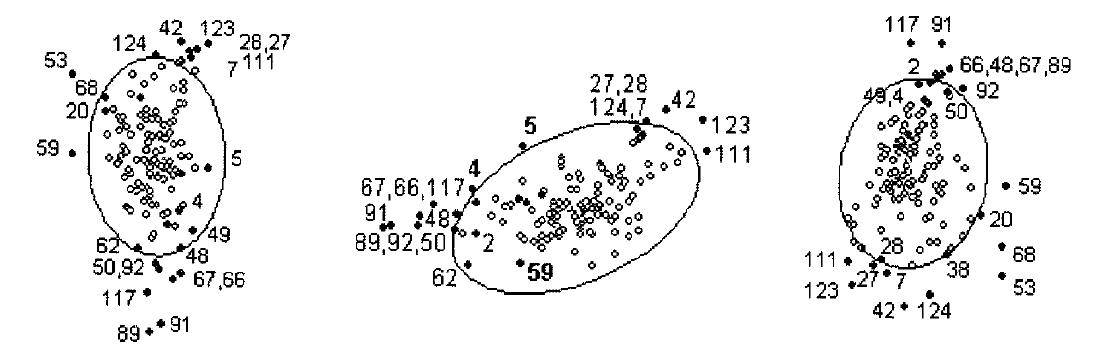
snapshots the tour projections with superimposed a 95% con- centration ellipses.